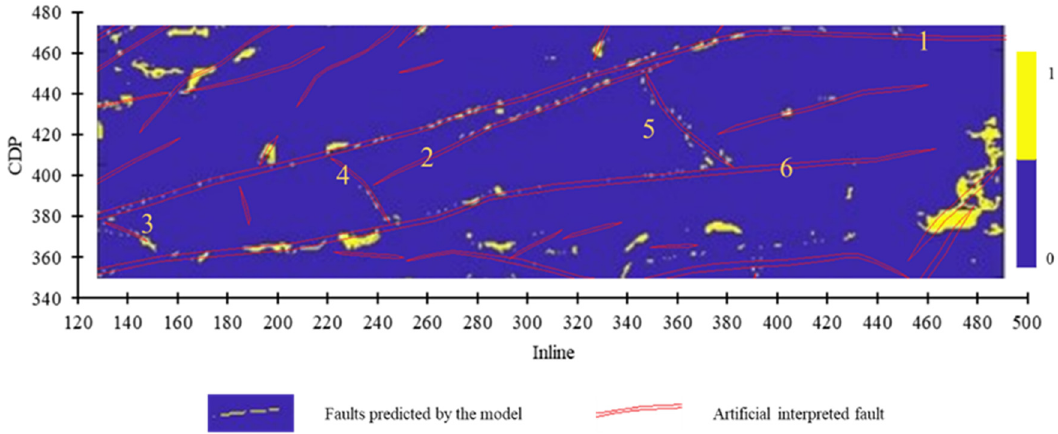
Figure 21. The prediction result of Faults 1–6 by Region D as training set .